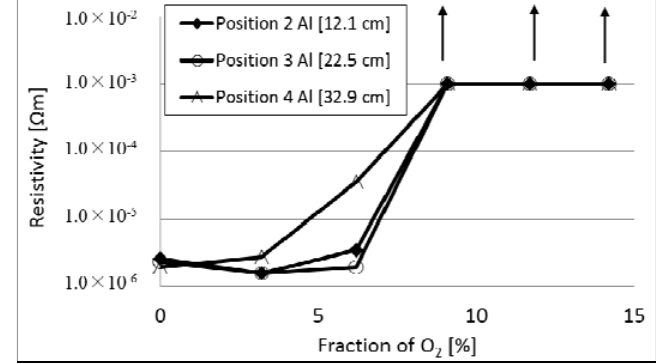
Figure 8. Relation between the resistivity and the fraction of O 2 (%) at different positions in the case with the Al outer anode.